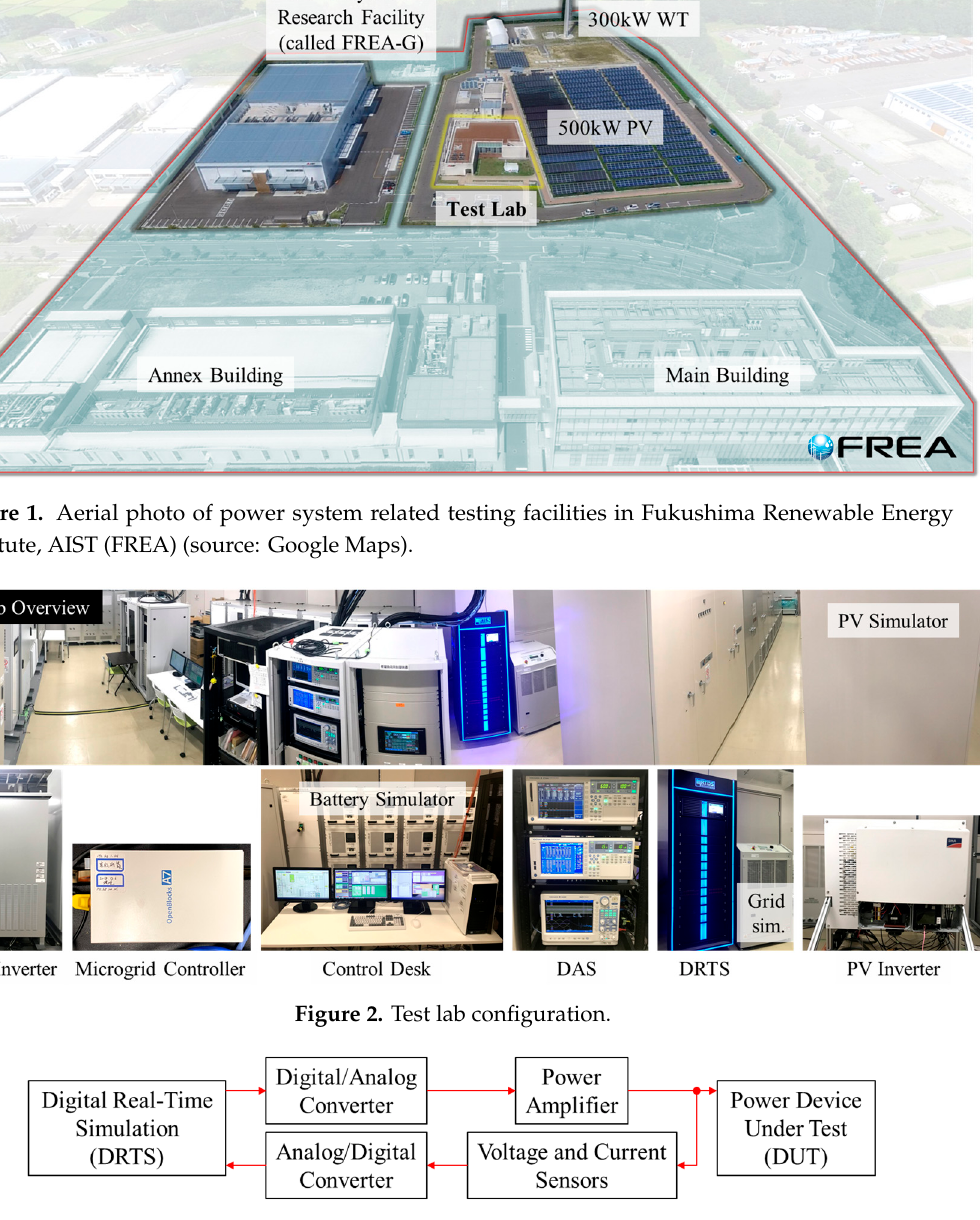
Figure 3. Digital real-time simulation (DRTS) and devices under test (DUT) interface set up.